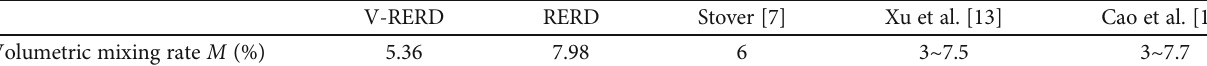
Table 2: Comparisons of the volumetric mixing rate.